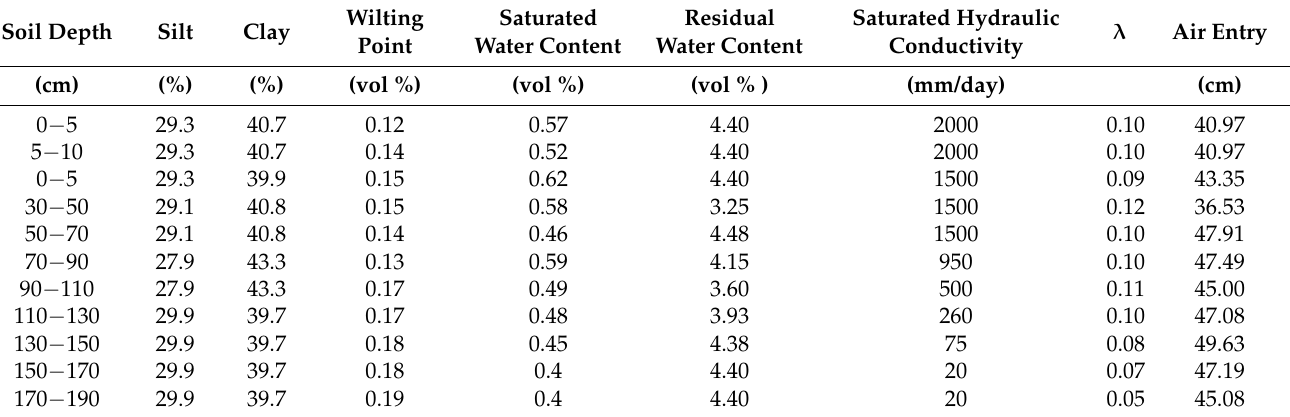
Table 1. Soil texture and hydraulic properties at study